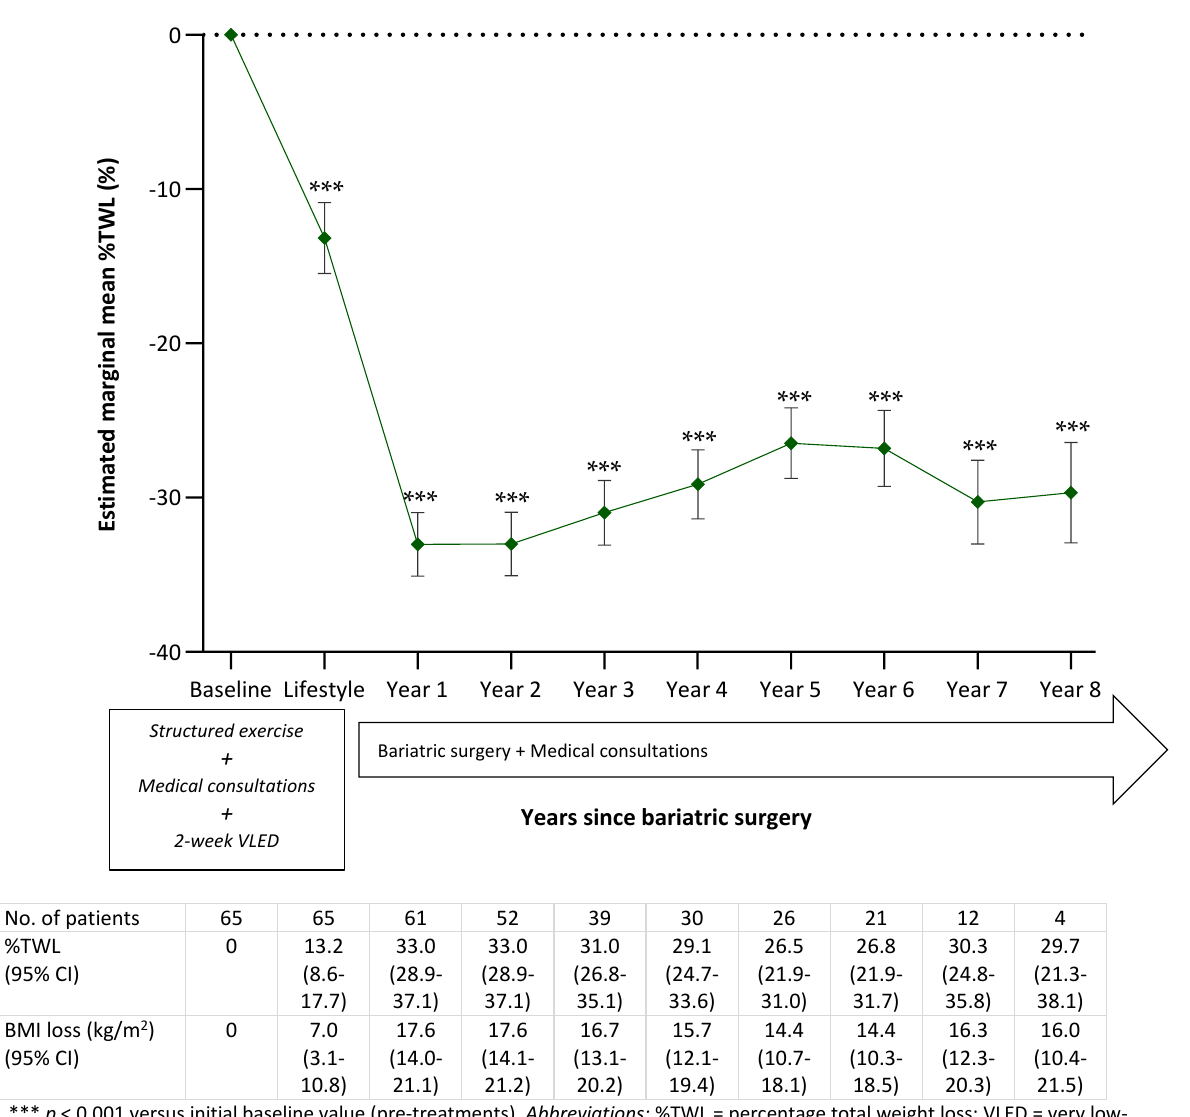
Figure 1. Modelled percentage total weight loss (%) from initial clinic visit (i.e., 1 year prior to surgery, with lifestyle modifications and medical consultations) to preoperation and year 8 post-bariatric surgery. The overall estimated marginal mean weight loss at each visit over time modelled from the mixed- effects model with random effects, taking into account the repeated measures nature of the data. Lines indicate modelled weight change from baseline based on mixed models adjusted for baseline factors (age at time of surgery, sex and race). A negative value represents weight loss based on pre-surgery weight. Data markers (estimated marginal mean values) indicate weight change data. Error bars represent the 95% CI